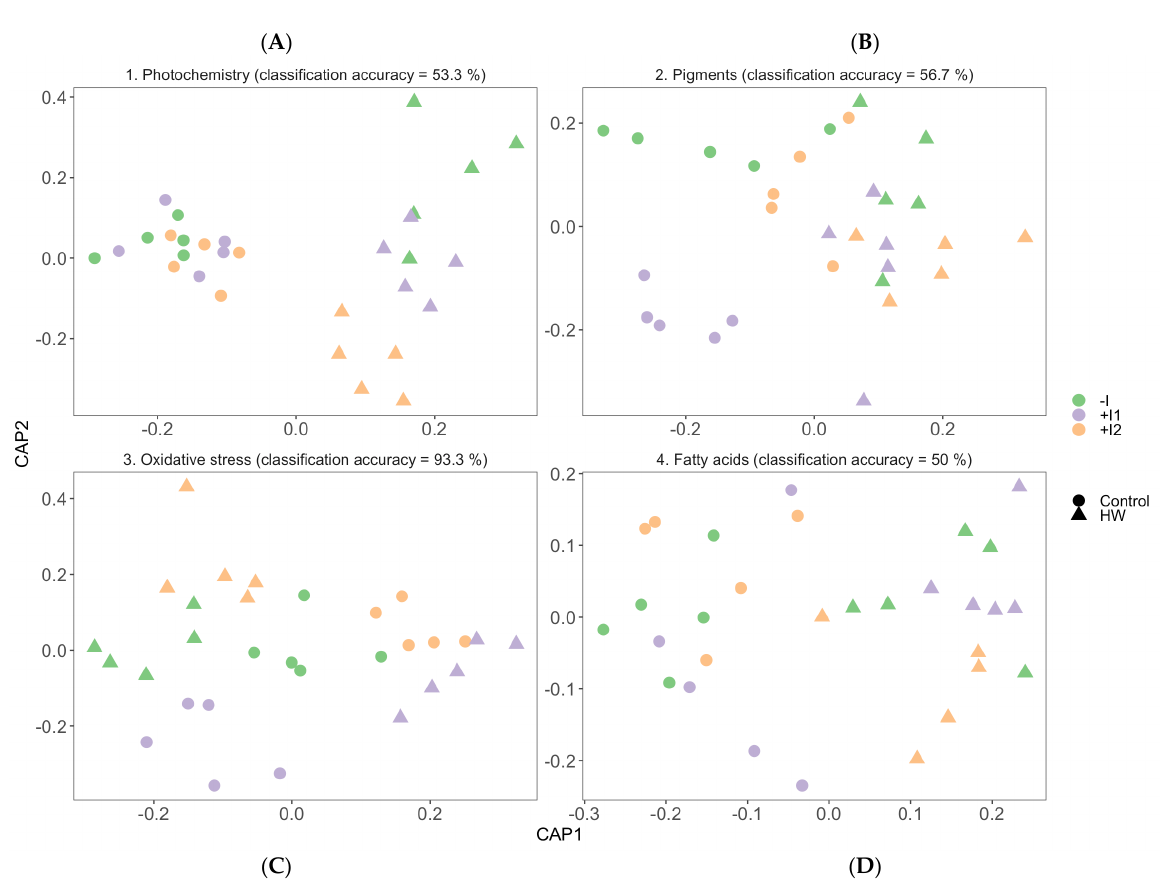
Figure 10. Canonical analysis of principal components (CAP) having as a basis, ( A ) the plant’s photochemistry, ( B ) pigment concentrations, ( C ) oxidative stress biomarker and ( D ) fatty acid concentration of non-inoculated ( − I) and marine PGPR consortia 1- and 2-inoculated (+I) Vitis vinifera leaves, under normal (control) thermal regimes and exposed to heatwave (HW) (average ± standard deviation, N = 5, letter denotes significant differences at p < 0.05).